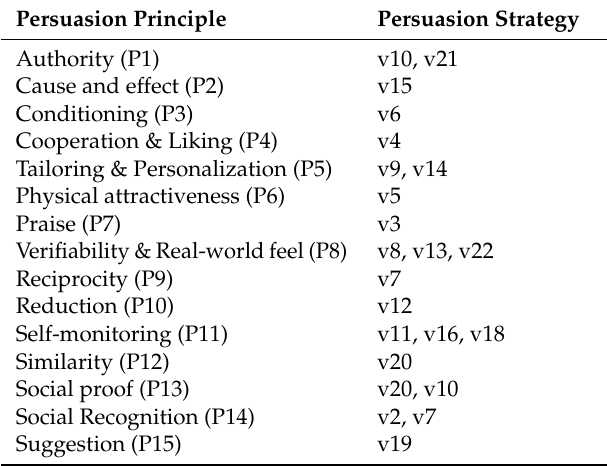
Table 3. Mapping of persuasive strategies to the persuasion